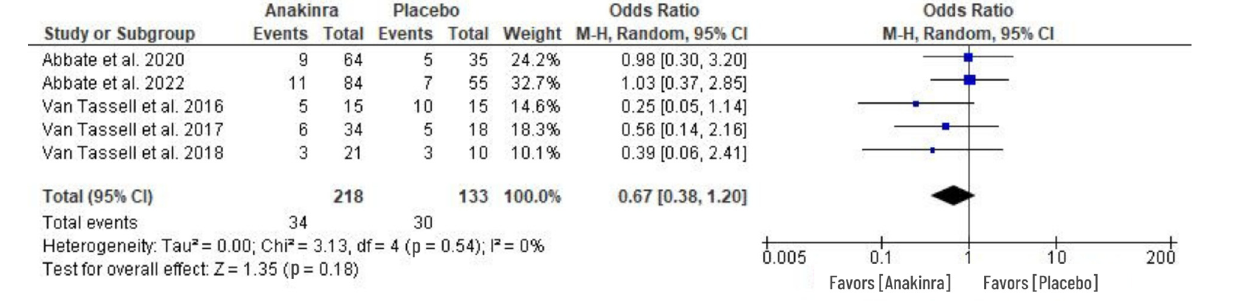
Figure 8. Adverse events associated with the use of anakinra vs. placebo treatment in HF patients [26,27,29–31].